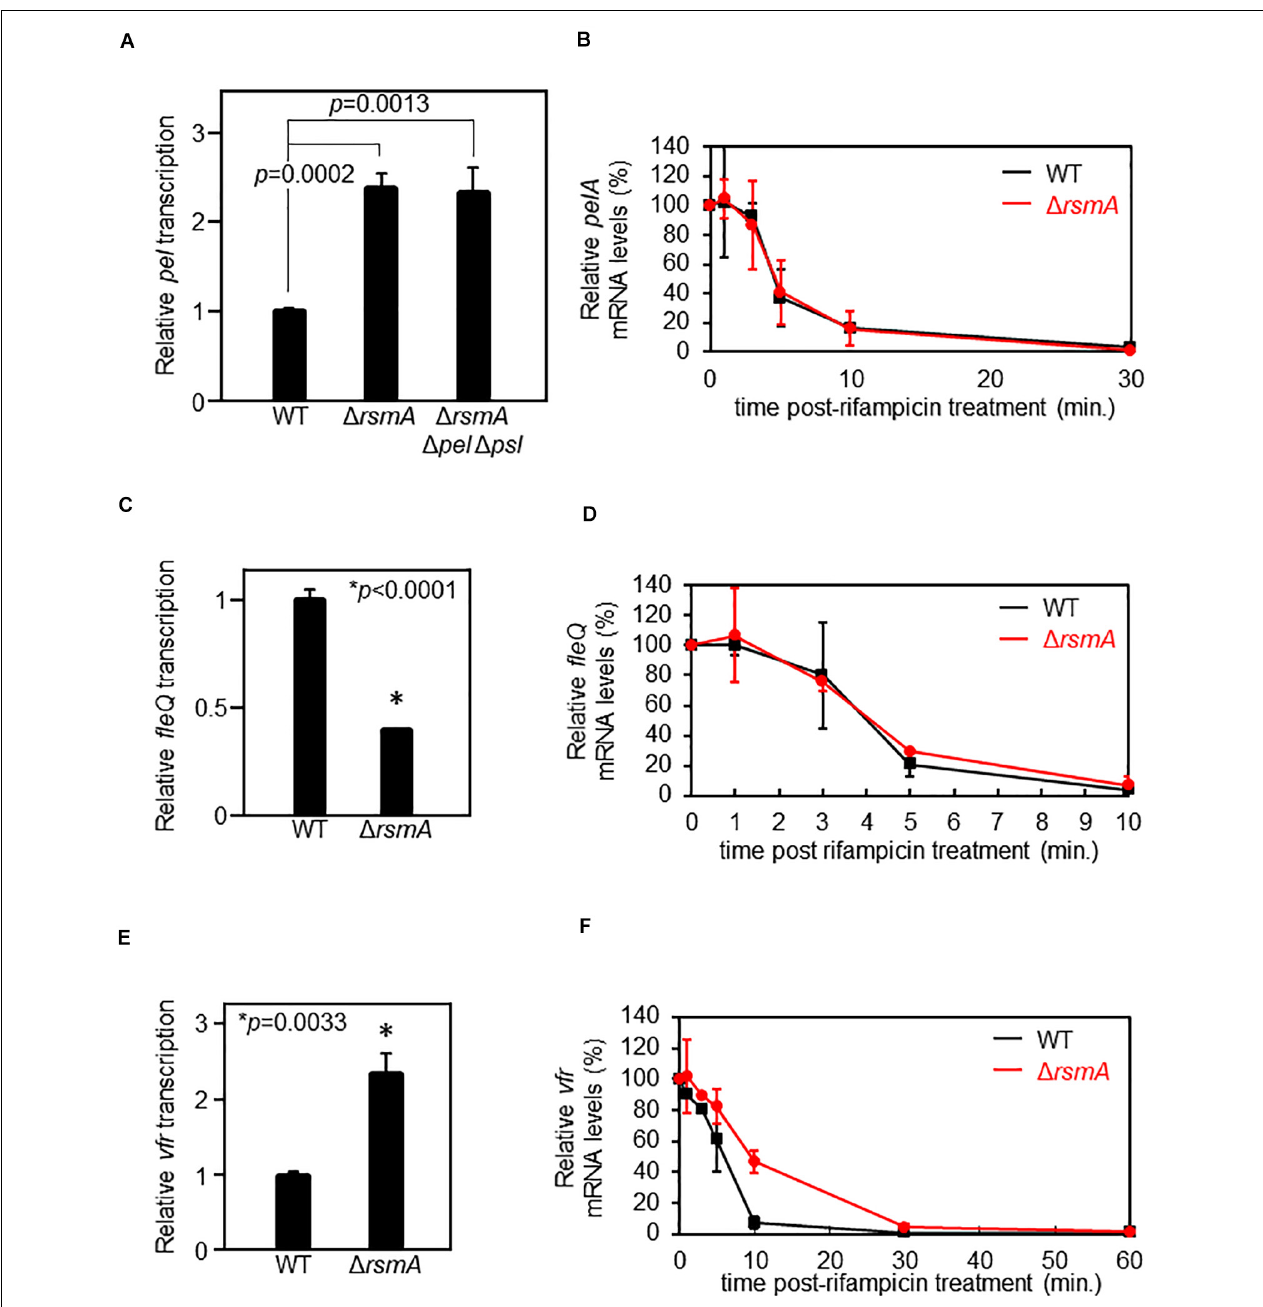
FIGURE 1 | RsmA does not directly regulate pel nor fleQ but represses vfr by altering mRNA stability. (A) Single-copy transcriptional lacZ fusion constructs reveal up-regulation of pel transcripts in the (cid:49) rsmA background as compared with wild type (WT). The (cid:49) rsmA strain overexpresses the PSL polysaccharides, which causes an elevation of intercellular c-di-GMP (Irie et al., 2012). Thus, we also tested a (cid:49) rsmA (cid:49) pel (cid:49) psl strain, which has low c-di-GMP due to the absence of PSL (Irie et al., 2012). Note that pel is equally up-regulated in the (cid:49) rsmA (cid:49) pel (cid:49) psl strain, demonstrating that the pel transcriptional phenotype of (cid:49) rsmA is PEL-, PSL-, and c-di-GMP-independent. The y -axis values are expressed as relative to WT as 1. (B) Real-time quantitative PCR (qPCR) at different time points after rifampicin treatment shows indistinguishable stabilities of the pelA transcript in the WT and (cid:49) rsmA strains. The y -axis values are expressed as relative to t = 0 as 100%. (C) Single-copy transcriptional lacZ fusion constructs reveal down-regulation of fleQ transcripts in the (cid:49) rsmA background as compared with WT. The y -axis values are expressed as relative to WT as 1. (D) qPCR at different time points after rifampicin treatment shows indistinguishable stabilities of the fleQ transcript in the WT and (cid:49) rsmA strains. The y -axis values are expressed as relative to t = 0 as 100%. (E) Single-copy transcriptional lacZ fusion constructs reveal up-regulation of vfr transcripts in the (cid:49) rsmA background as compared with WT. The y -axis values are expressed as relative to WT as 1. (F) qPCR at different time points after rifampicin treatment show that vfr mRNA is less stable in WT as compared with the (cid:49) rsmA strain. The y -axis values are expressed as relative to t = 0 as 100%.